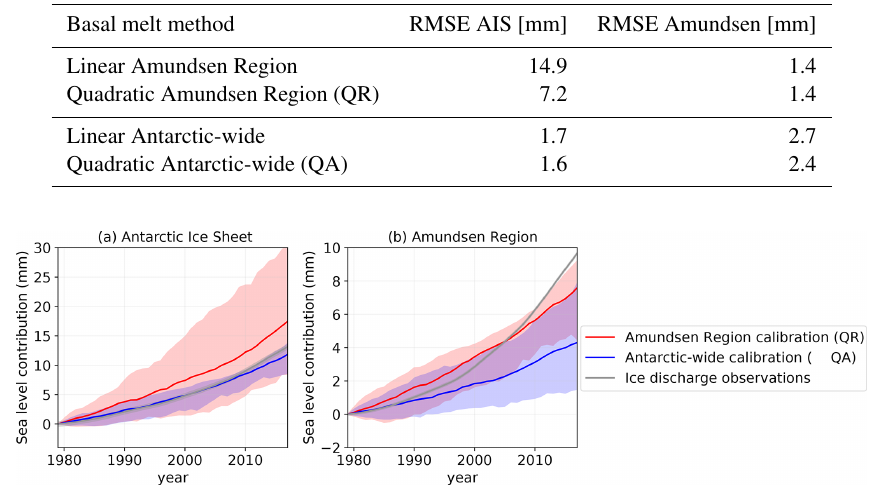
Figure 6. Impact of calibration target region on sea level illus333trated by hindcasts showing the sea level contribution over the period 1979–2017 based on all calibrated ESM-RF pairs for the total AIS (a) and the Amundsen Region (b) . The historical experiment is extended with SSP2-4.5 scenario for the years 2015–2017. The red lines indicate the median contribution based on the Amundsen Region calibration, whereas the blue lines indicate the median contribution for the Antarctic-wide calibration. Only the quadratic parameterisation with thermal forcing near the ice shelf base is shown. The observation-based changes in ice discharge from Rignot et al. (2019) are shown in grey. The shaded area indicates the associated likely range (17th to 83rd percentiles) for the modelled response and the observational error for the Rignot et al. (2019)